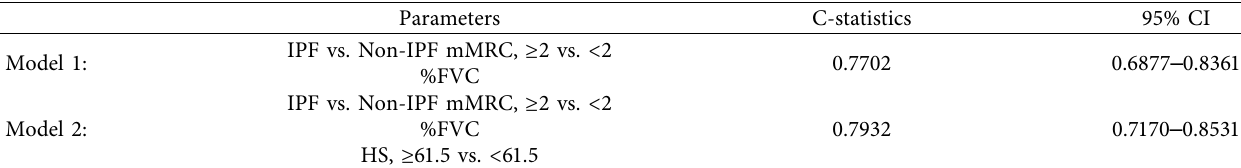
Table 4: Predictive models of occurrence of AE-IIPs with/without hemosiderin score. Parameters